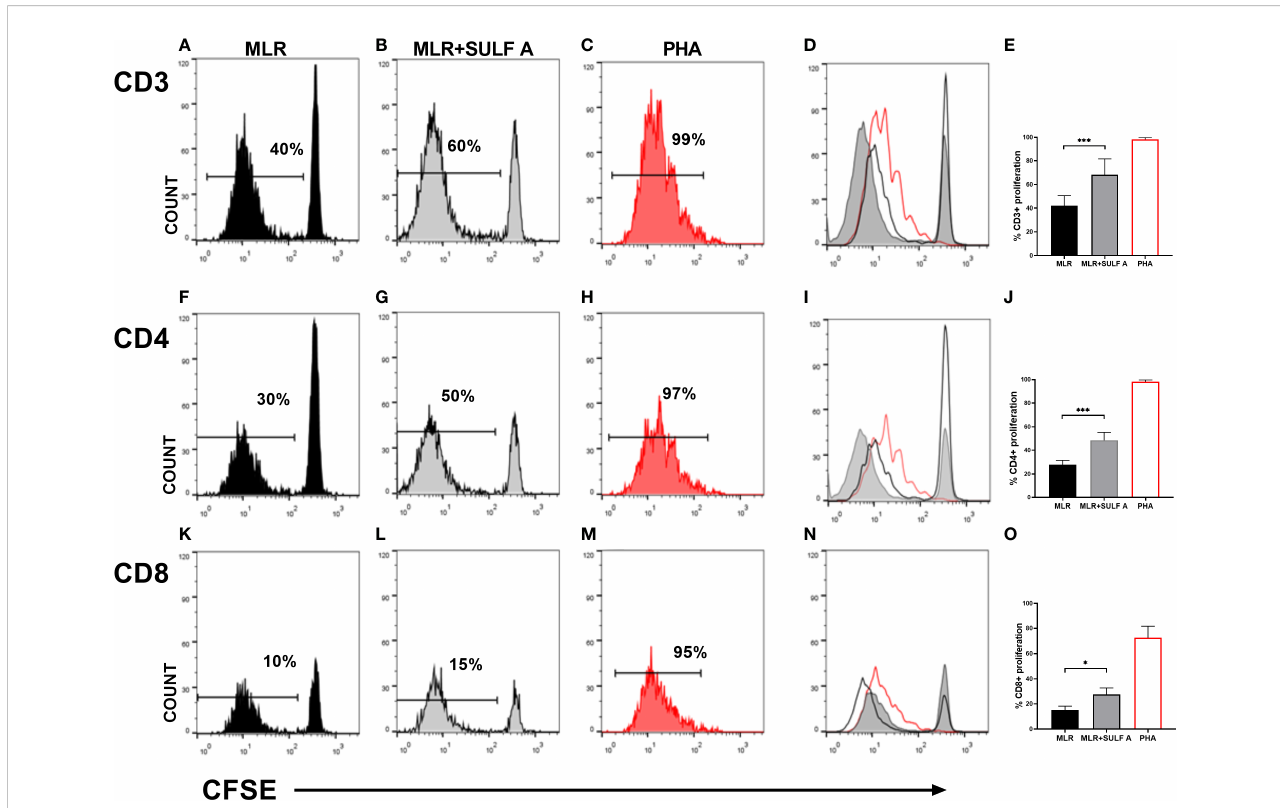
FIGURE 1 T cells proliferation induced by SULF A. Naïve T cells proliferation was assessed by CFSE dilution after 7 days of co-culture. The analysis was performed on 5000 live/T CD3+ cells. Histogram plots relative to one representative experiment are shown for CD3+ panels (A – D) , for CD4+ panels (F – I) and for T CD8+ panels (K-N) . Numbers in the plots indicate the percentage of proliferating cells. Panels (D) (T CD3+), (I) (T CD4+), (N) (T CD8+) show the overlay of the three experimental conditions for each subset. The bar graphs (E, J, O) represent the mean of 6 experiments. Gate strategy is reported in Supplementary Figure 1. MLR = untreated cocultures; MLR+SULF A = cocultures treated with 10 m g /mL SULF A; PHA= cocultures treated with 1 µg/mL phytohemagglutinin (positive control). Statistical analysis was performed by one-way Anova non parametric test. * P < 0.05; *** P <